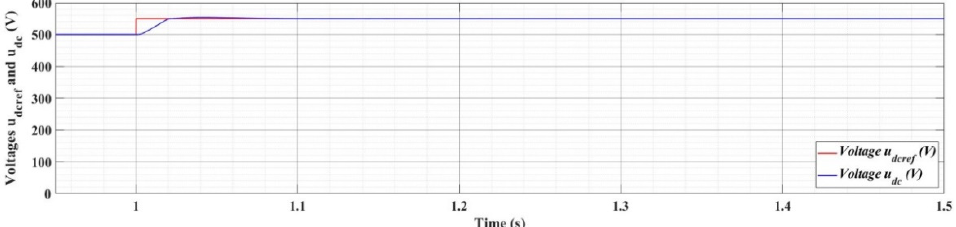
Figure 47. The time evolution of voltage u dc for a step variation of the u dcref reference voltage from 500 V to 550 V using SMC- and SYN-type controllers and the RL-TD3 agent for the correction of the i dref command (signal evolution of the type 2 PV array).